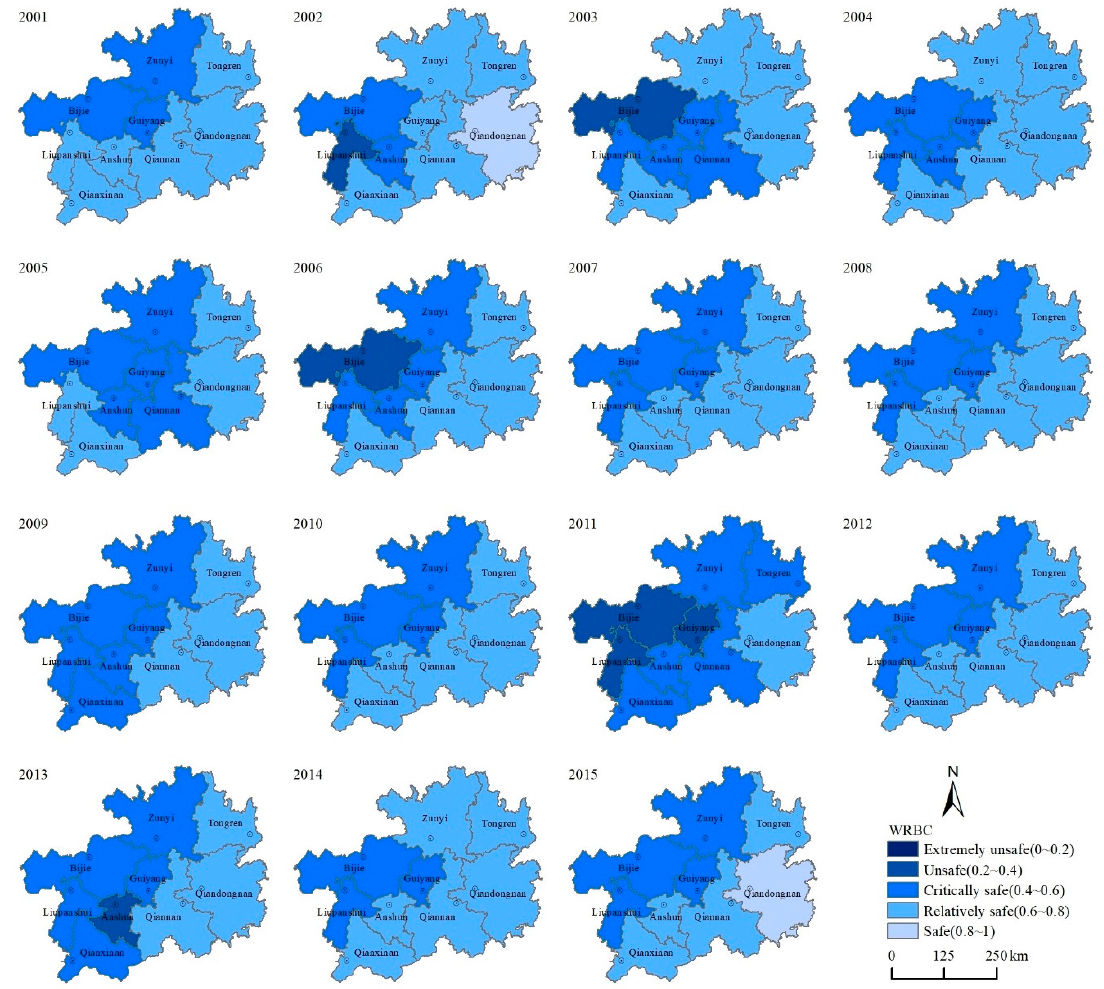
Figure 7. Spatiotemporal patterns of the WRBCI (Water Resources Background Conditions Index) in various cities and states in Guizhou Province in 2001–2015.